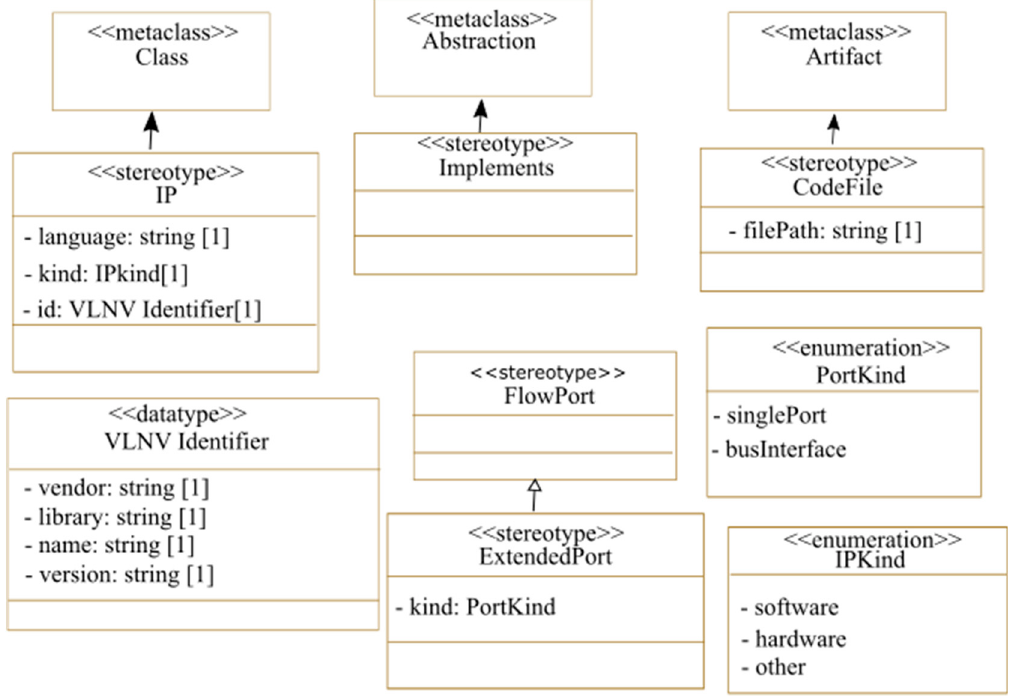
Figure 4. Proposed extensions to the MARTE profile for IP deployment.